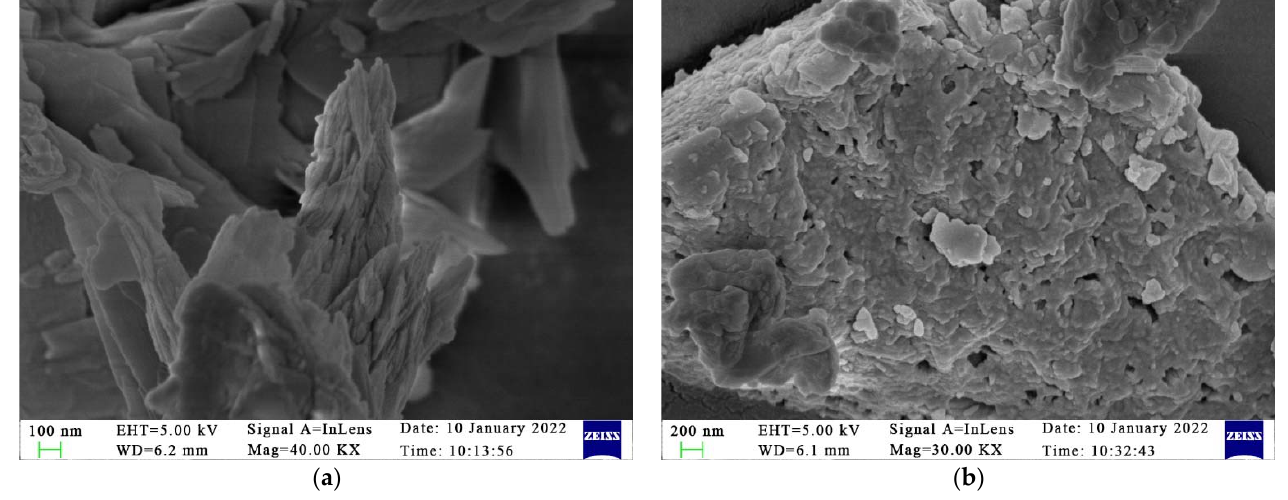
Figure 8. 27 Al NMR of ordinary kaolin ( a ) and metakaolin ( b ). * indicates rotational bands.